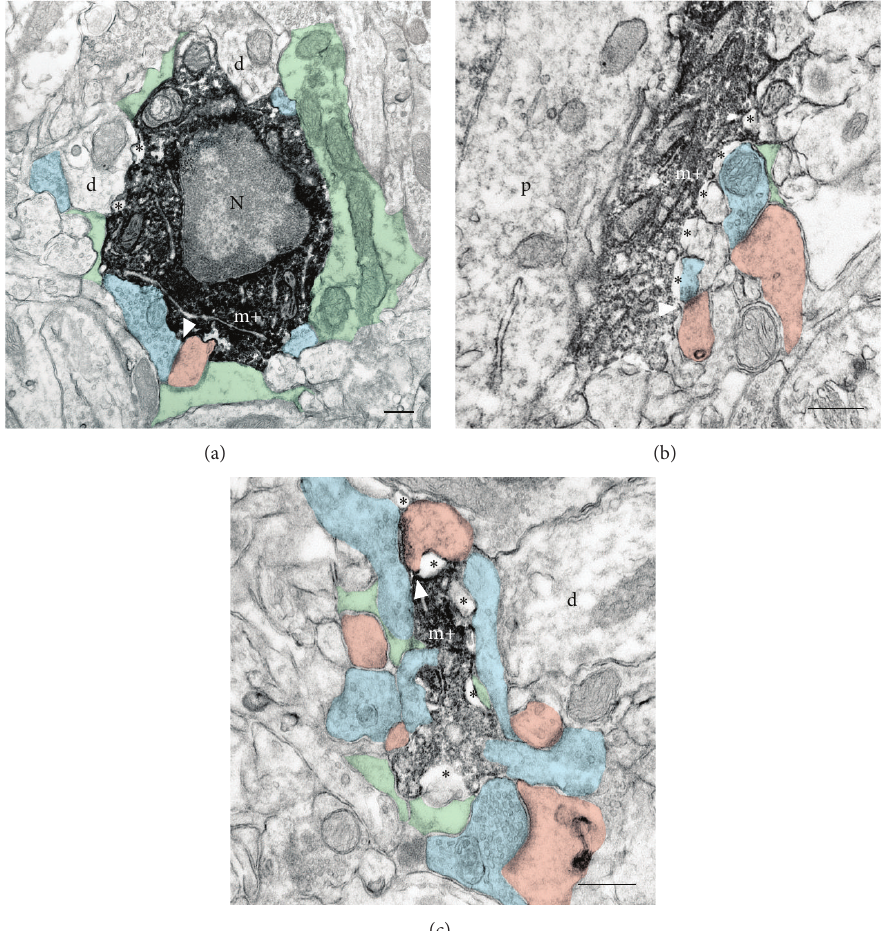
Figure 1: Ultrastructural relationships between microglia and synaptic elements in physiological conditions. Electron microscopy examples of Iba1-immunostained microglial (m+) cell body (a), as well as large (b) and small (c) processes, showing direct juxtaposition with axonal terminals (in blue), dendritic spines (in pink), astrocytic processes (in green), and synaptic cleft (arrow) in adolescent mouse visual cortex. d: dendrite; N: nucleus; p: perikaryon; asterisks: extracellular space. Scale bars: 250nm. Reproduced from Tremblay et al.